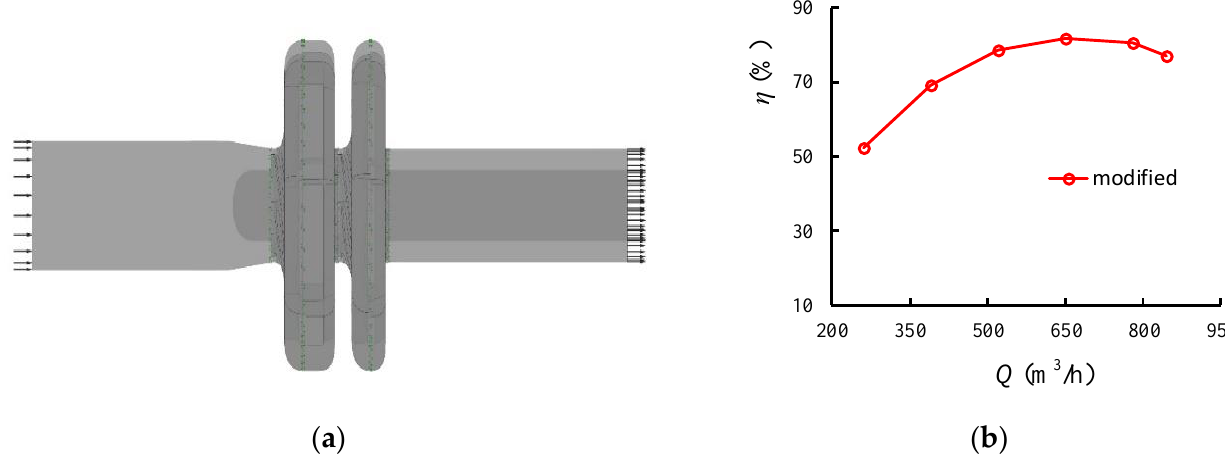
Figure 15. Secondary calculation domain of the diffuser with a new structure. ( a ) Calculation domain; ( b ) efficiency curve of the improved structure.